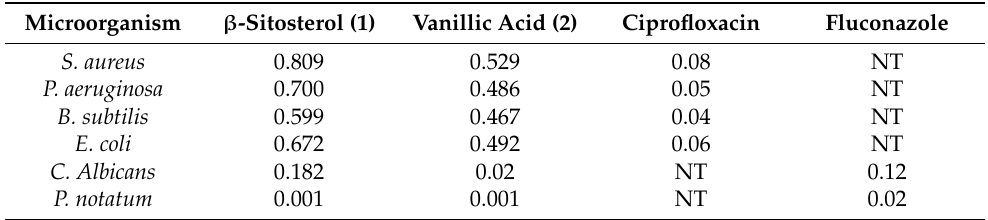
Table 2. MIC values of β -sitosterol ( 1 ) and vanillic acid ( 2 ) isolated from D. bupleuroides using disc diffusion assay and expressed in mg/mL. Microorganism β -Sitosterol (1) Vanillic Acid